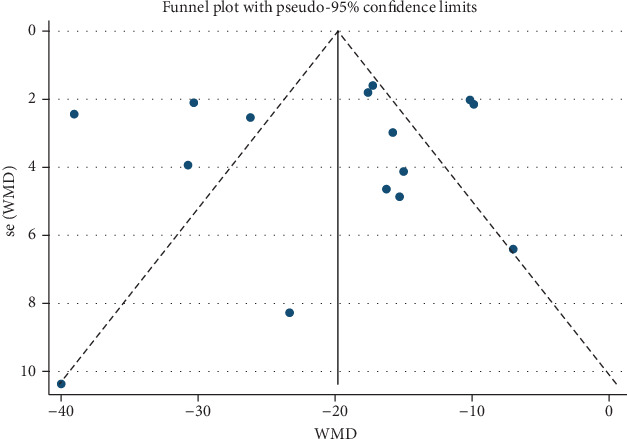
Funnel plot for assessment of publication bias among the included studies.